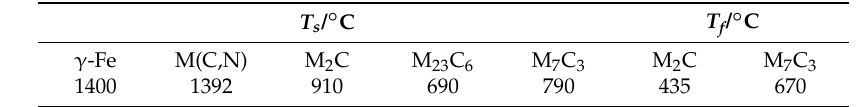
Figure 1. Equilibrium phase precipitations in nitrogen ‐ microalloyed high ‐ Mn austenitic hot work die steel (HMAS ‐ N) calculated using Thermo ‐ Calc (M represents metallic element atom; C represents carbon atom). Table 4. Calculation results of transformation temperatures of precipitates in steel, calculated using Thermo ‐ Calc.